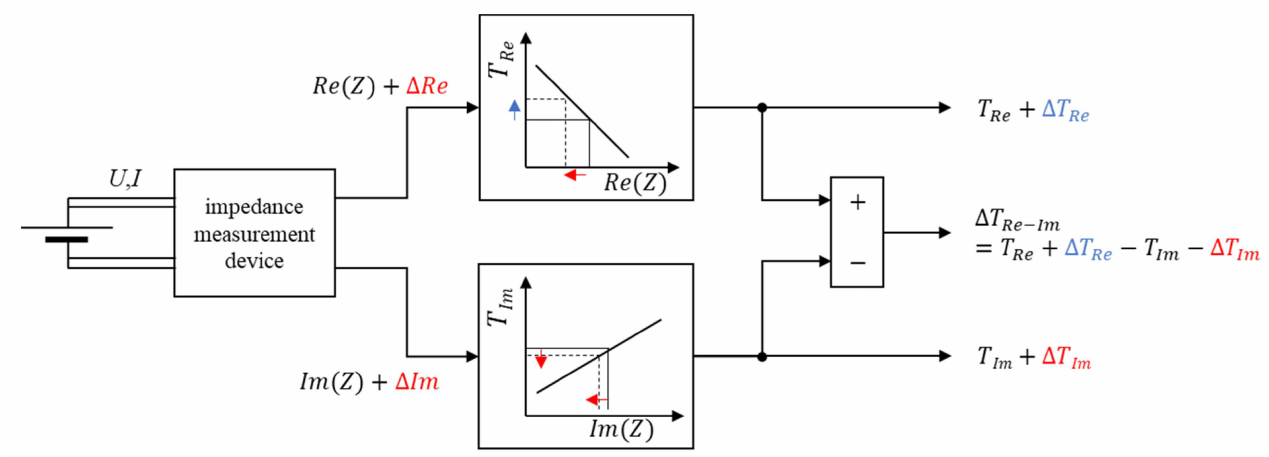
Figure 4. Block diagram of the method to infer a plating-sensitive signal ∆ T Re − Im . Changes in the measured and inferred quantities during plating are given as ∆ Im and ∆ Re and are colored blue for positive and red for negative